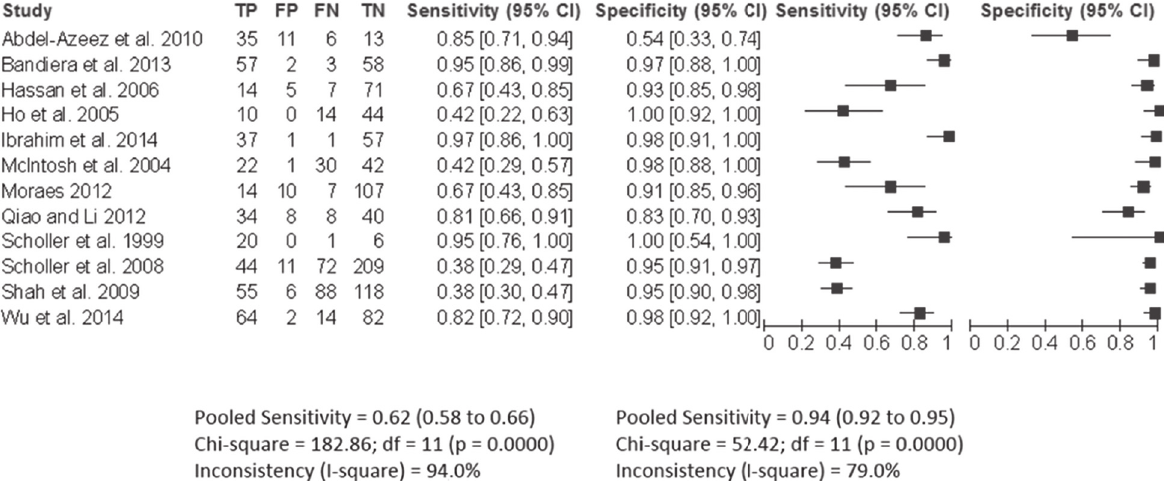
Figure 3 - Florest plot showing of sensitivity and specifi city pool.